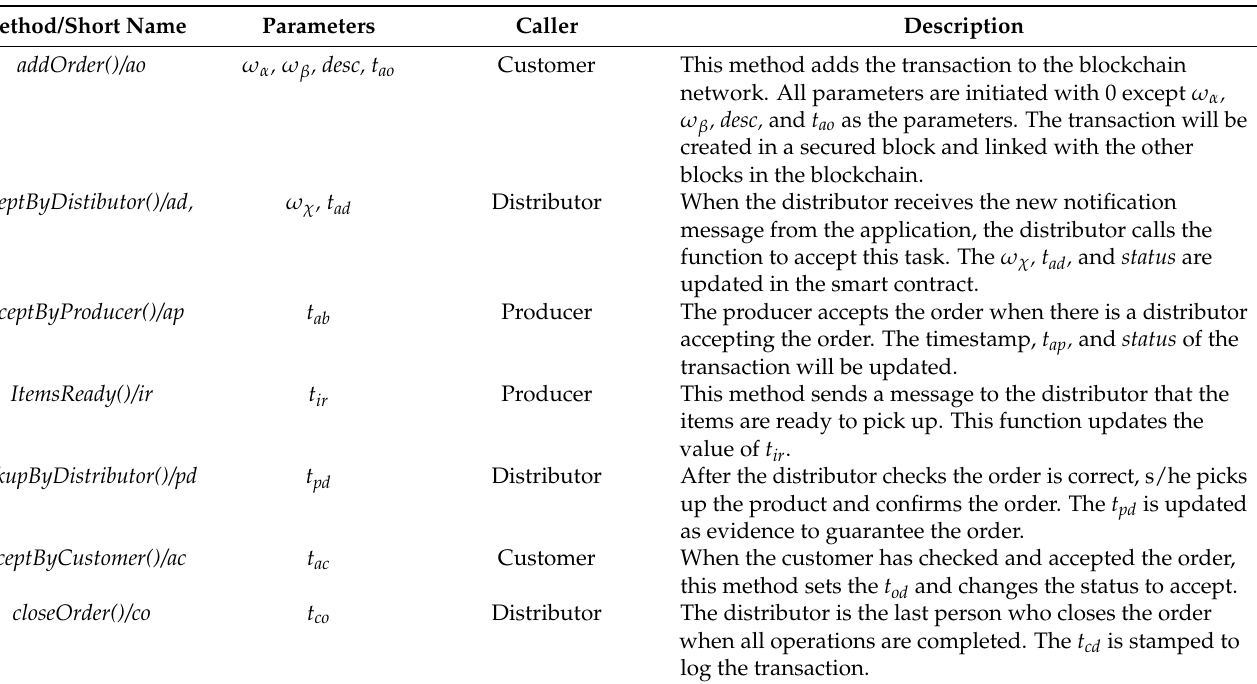
Table 2. The smart contract method to secure a home delivery